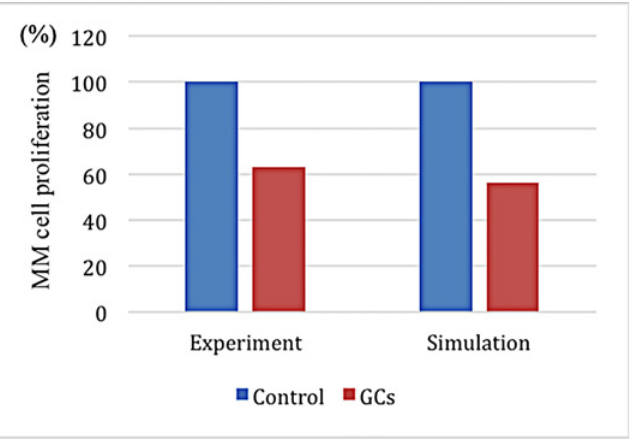
Fig 11. A comparison of the experimental[17] and simulated data after GC treatment.